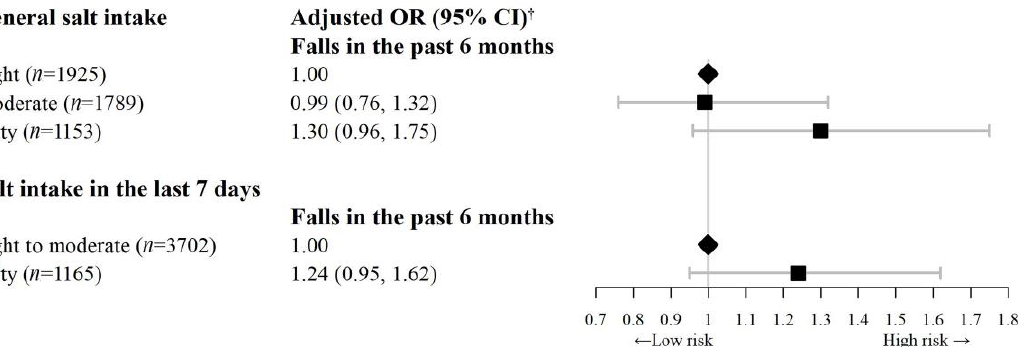
Figure 2. Association of salt intake with TUGT score (second) on 4867 participants of the Guangzhou Biobank Cohort Study. CI = confidence interval, TUGT = timed up-and-go test. † Adjusted β (95% CI): adjusted for sex, age, education, family income, occupation, physical activity, smoking status, alcohol use, body mass index (BMI), self-rated health, and self-reported hypertension.